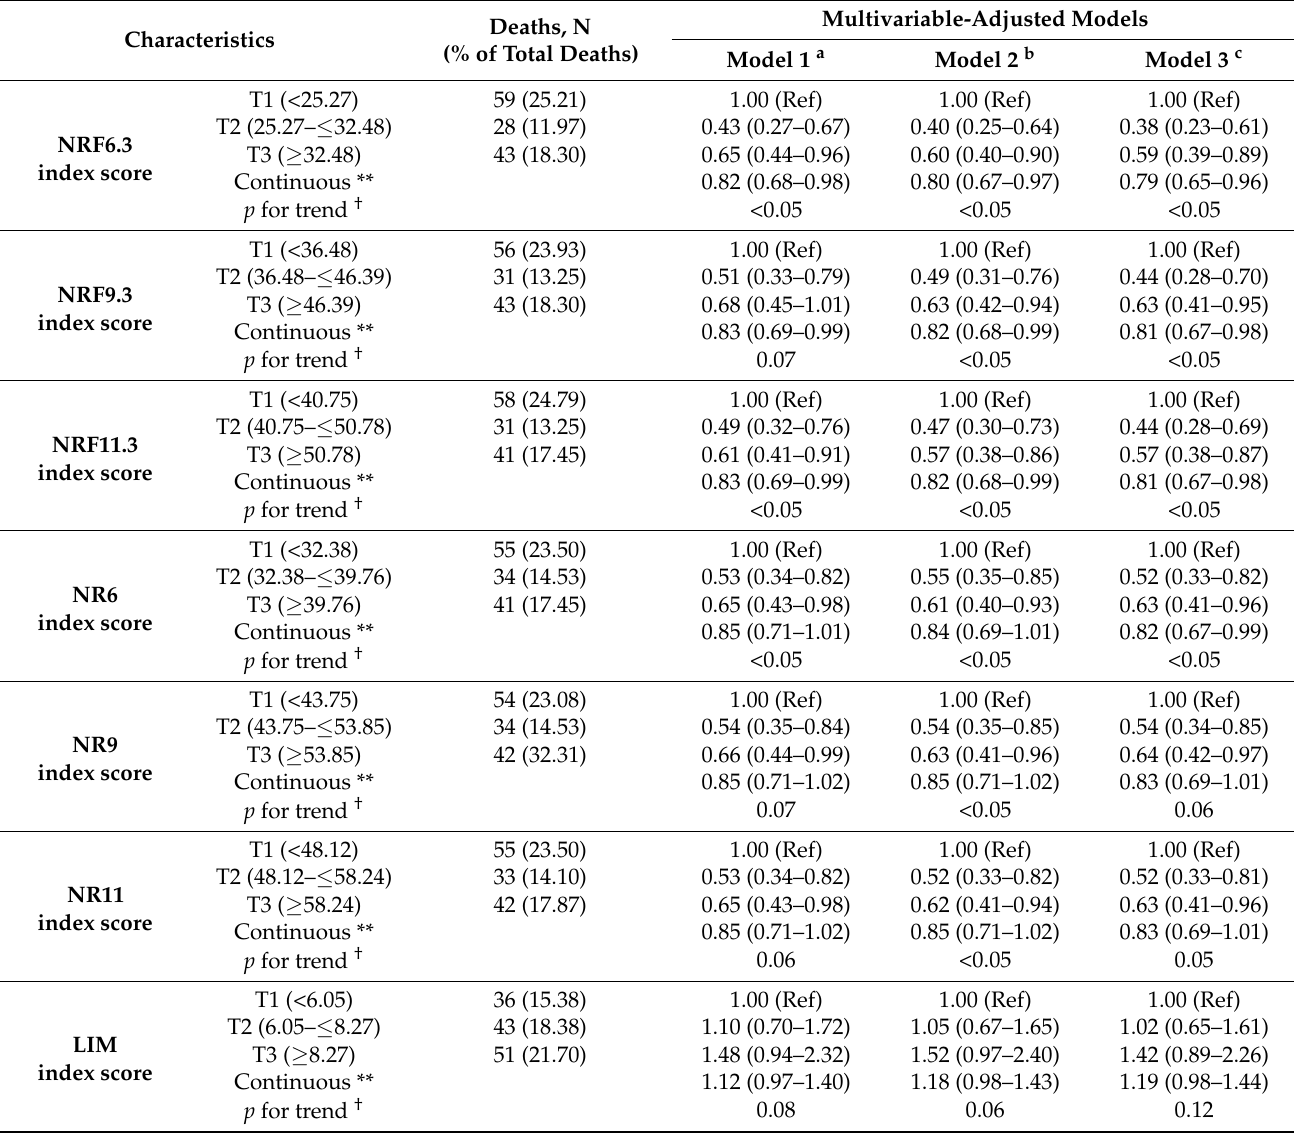
Table 2. The associations of NR, LIM, and NRF index scores with overall survival of 703 ovarian cancer patients